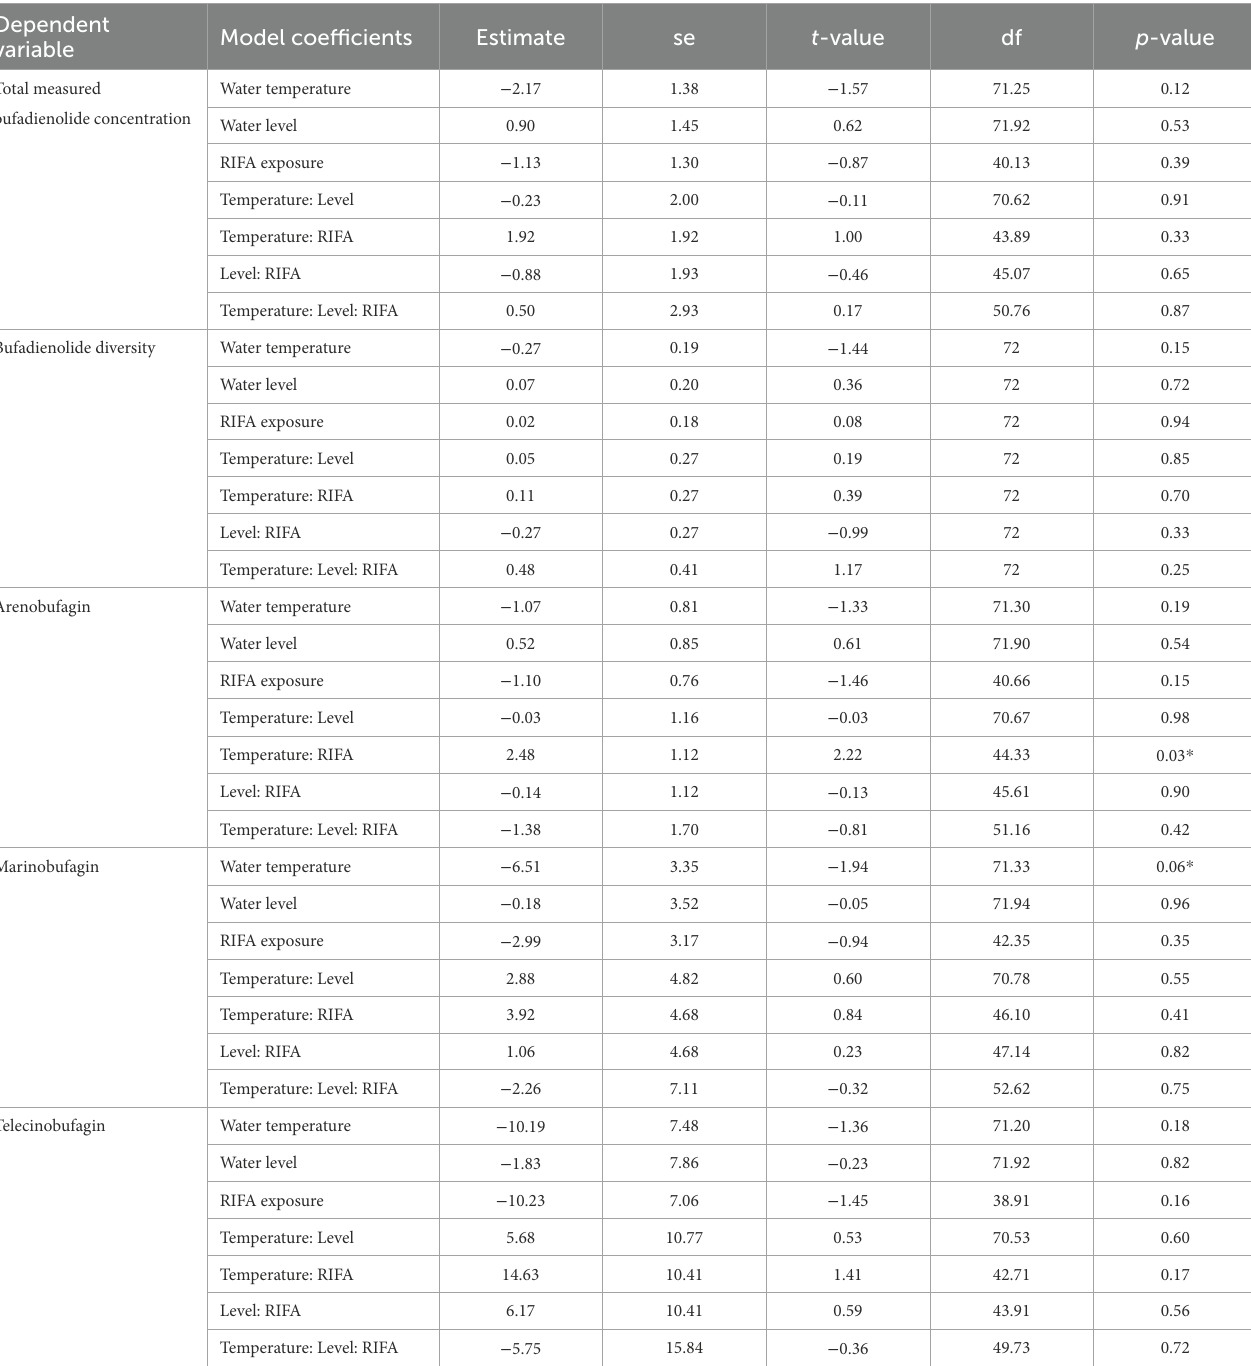
TABLE 4 Results of mixed-effects models for bufadienolide